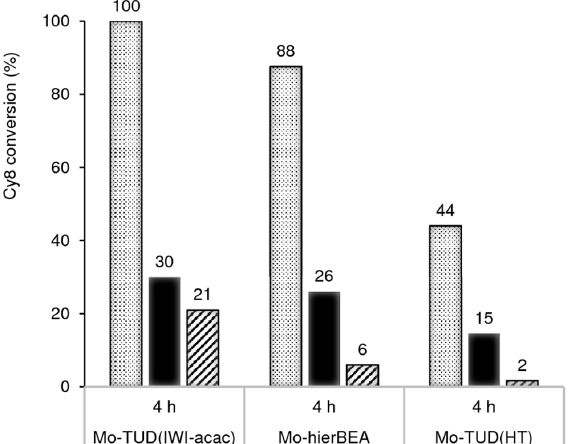
Figure 8. Influence of the type of oxidant solution on catalytic epoxidation of cis -cyclooctene (Cy8), at 70 ◦ C (4 h), using the oxidant/solvent systems: TBHP in decane/TFT (dotted bars); TBHP in water/CH 3 CN (black bars); H 2 O 2 in water/CH 3 CN (diagonally-striped bars). Epoxide selectivity was always